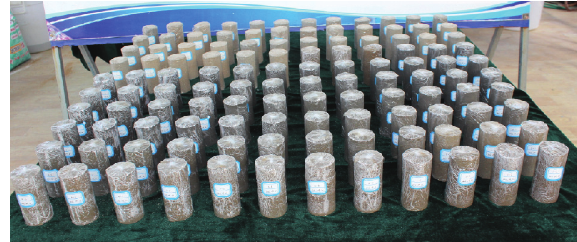
Figure 5: Test blocks of similar materials.